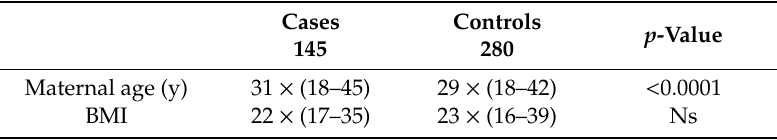
Table 1. Clinical characteristics of women with endometriosis and